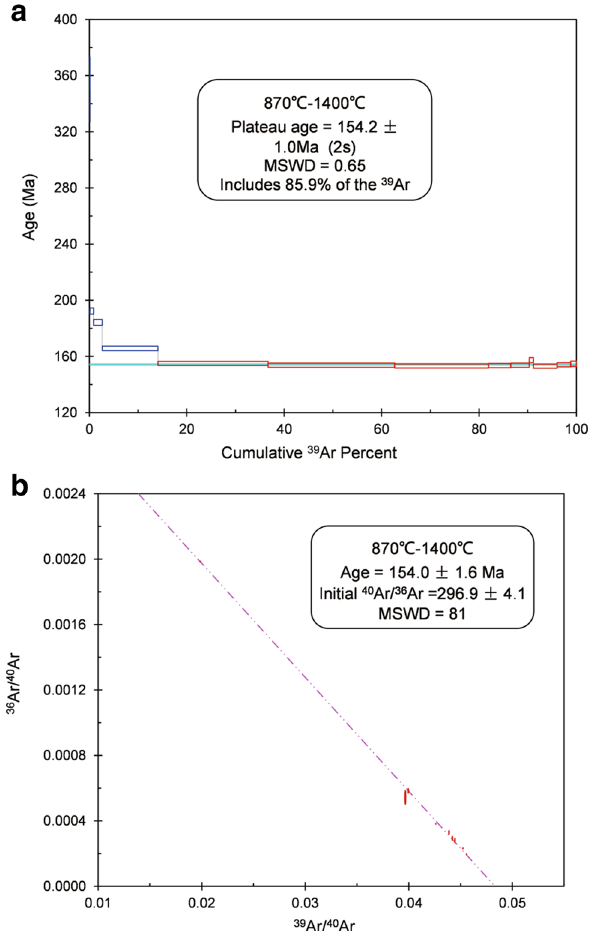
Figure 11. Plateau ( a ) and isochron ( b ) Ar–Ar age of muscovite from mineralizing greisen in the Shizhuyuan deposit. ISOPLOT software (Ludwig, v. 3.75, 2012, copyright@ BGC Berkeley Geochronology Center, 2006, available from: http://www.bgc.org/isopl ot_etc/isopl ot.html) was used for data